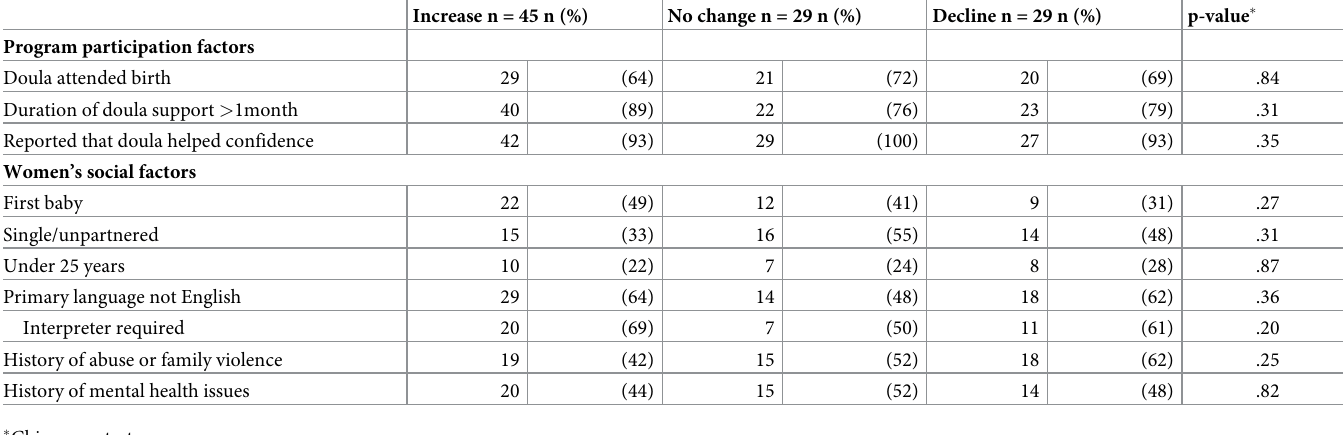
Table 5. Program participation factors and women’s social factors’ associations with pre-post birth confidence.